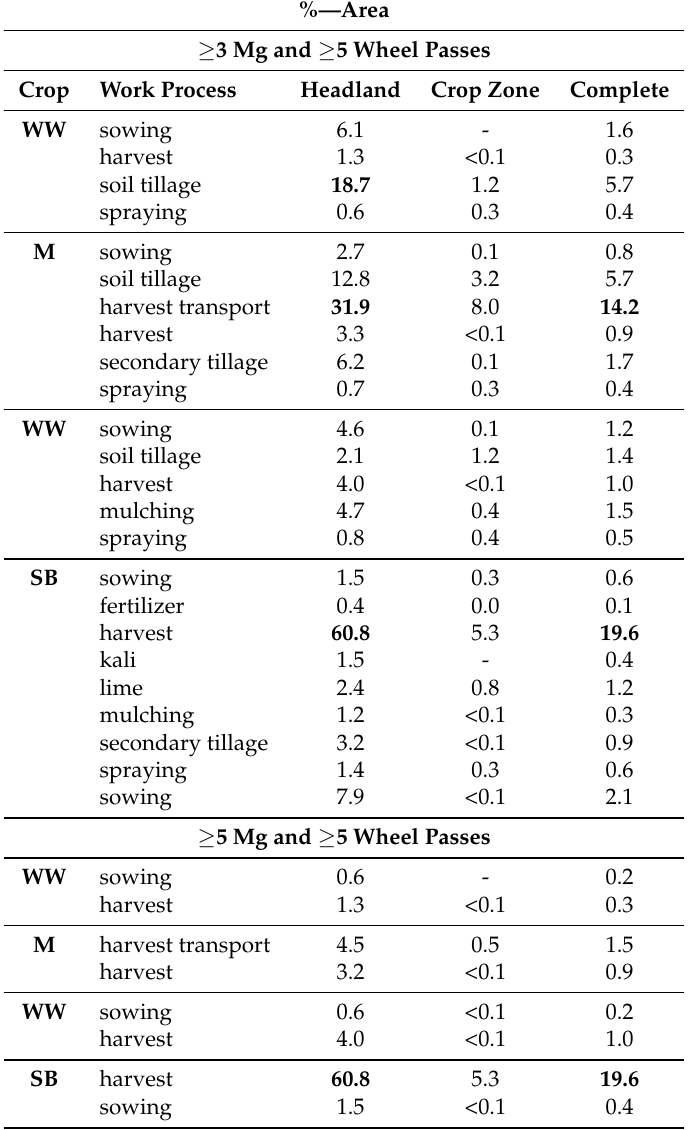
Table 4. Area percentage of the field for single work processes with over five wheel passes and wheel loads greater than 3 Mg and 5 Mg. In bold are the area shares above